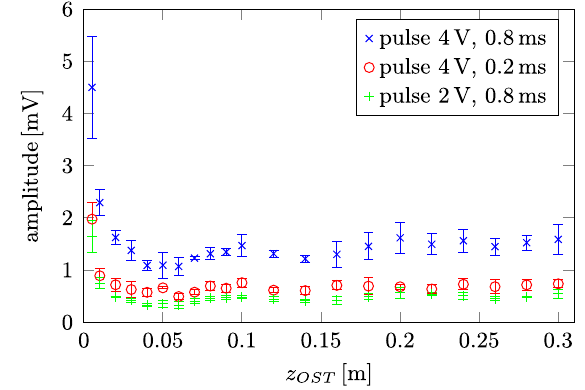
ing path z OST of the Second Sound wave. Three different shapes of the heating pulse are compared.